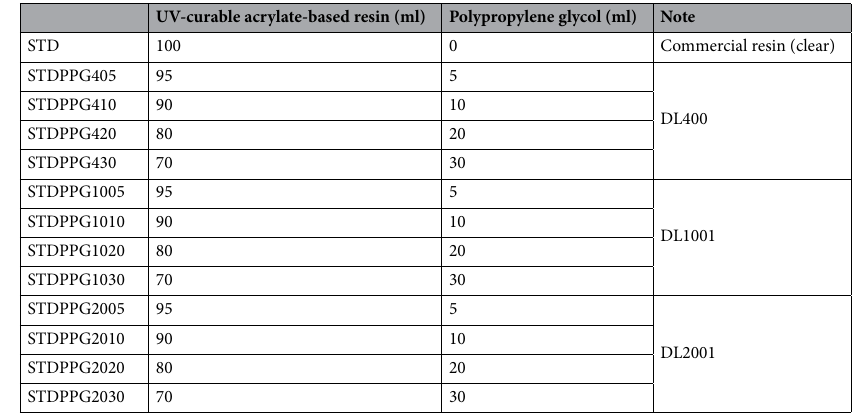
Table 2. Polymers blending ratio.